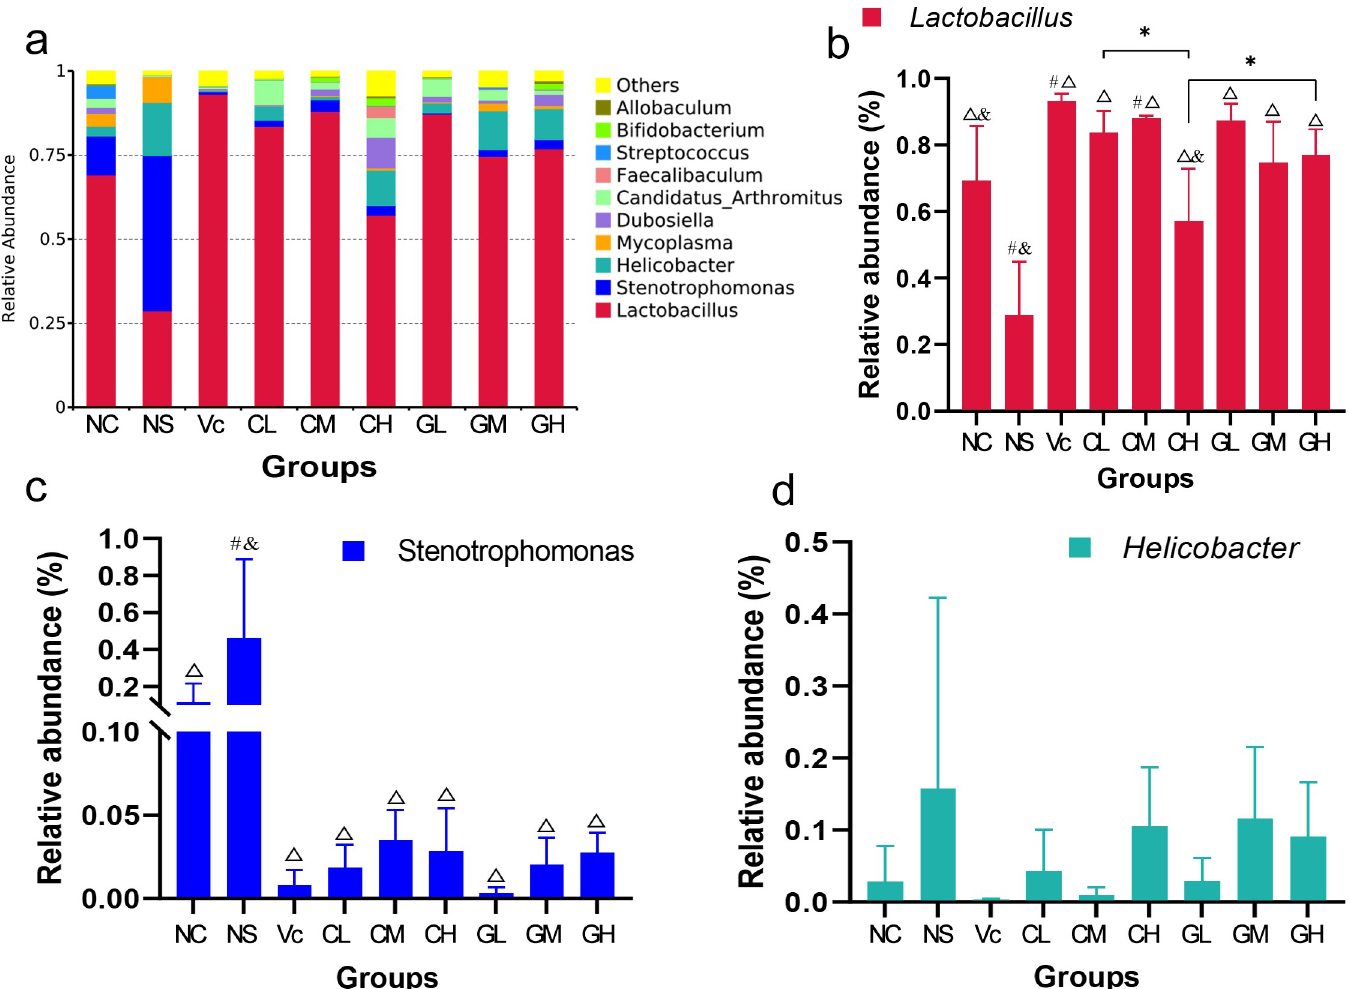
Fig 4. Results of relative abundance of intestinal bacteria. a. the relative abundance of intestinal bacteria in all groups; b, c and d. statistical results of relative abundance of Lactobacillus , Stenotrophomonas , and Helicobacter in different groups, respectively. NC: Normal control; NS: Negative control; Vc: Positive control; CL, CM, CH represents low-, middle-, high-concentration cow whey protein intervention group, respectively. GL, GM, GH represents low-, middle-, high-concentration goat whey protein intervention group, respectively; #, p < 0.05, compared with the C; ρ , p < 0.05, compared with the NS; &, p < 0.05, compared with the Vc; � Correlation is significant at the 0.05